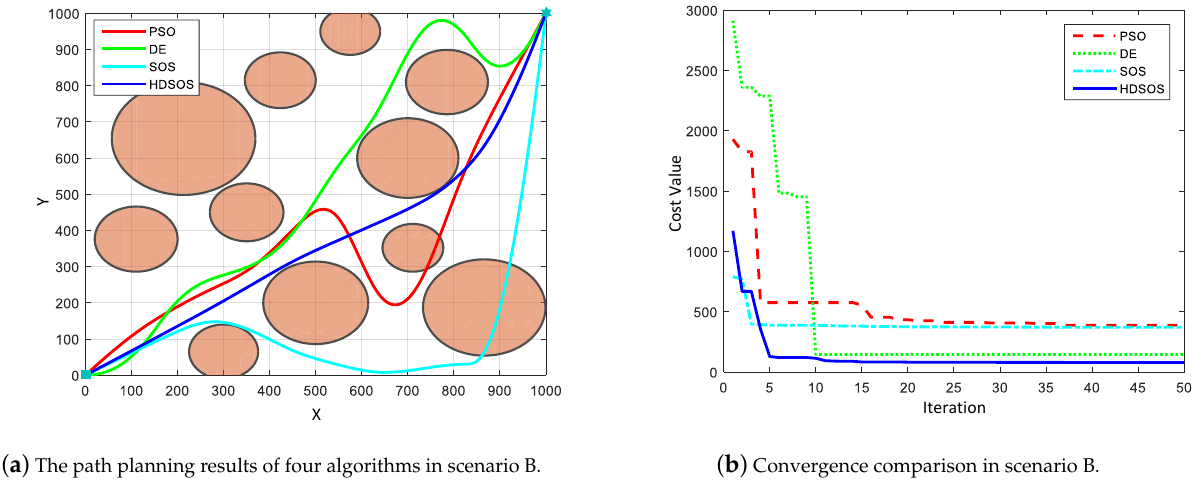
Figure 6. The comparative results for two-dimensional scenario